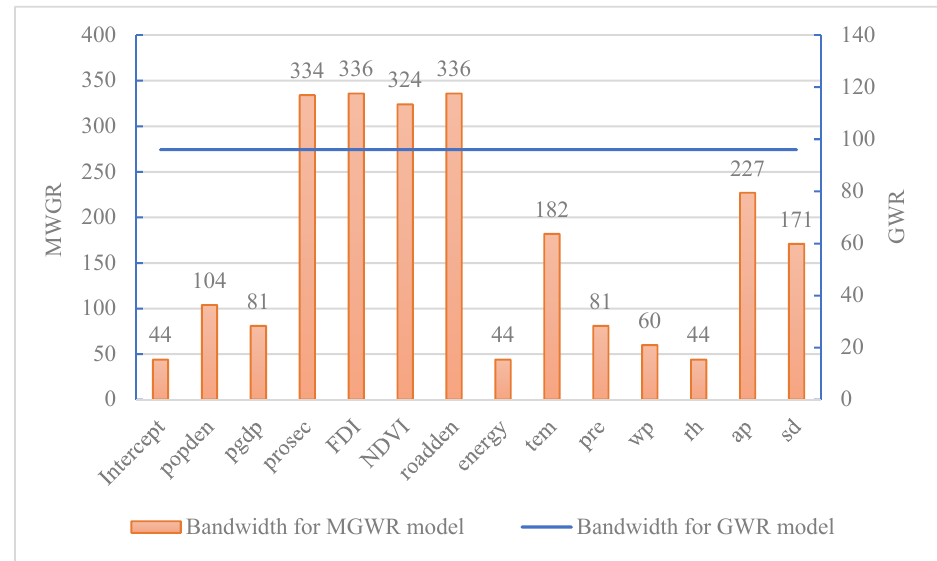
Figure 5. Bandwidth comparison between the GWR and MGWR models.